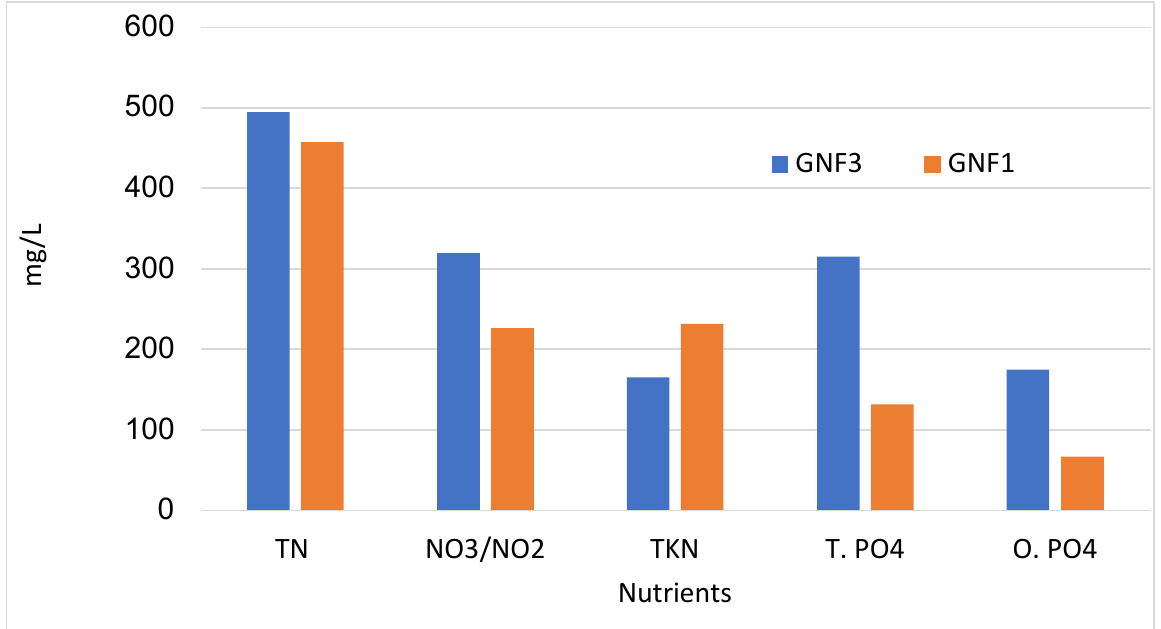
Figure 4. Summary of the nutrients in GNFs.